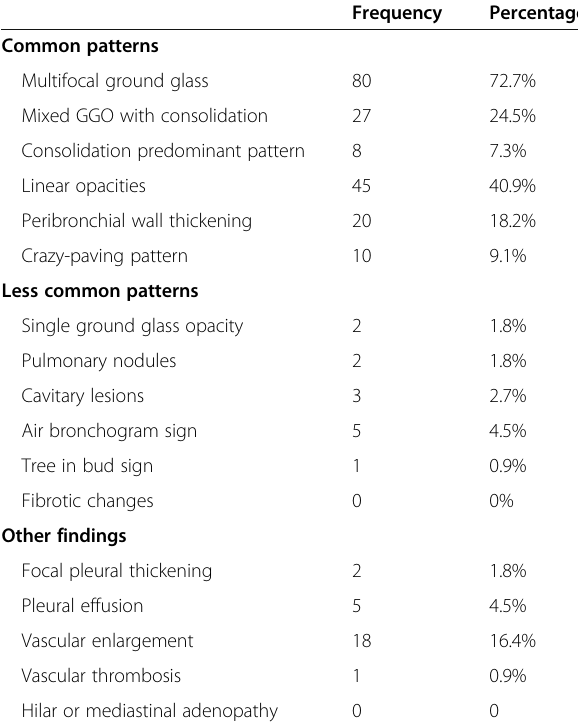
Table 2 Different CT imaging